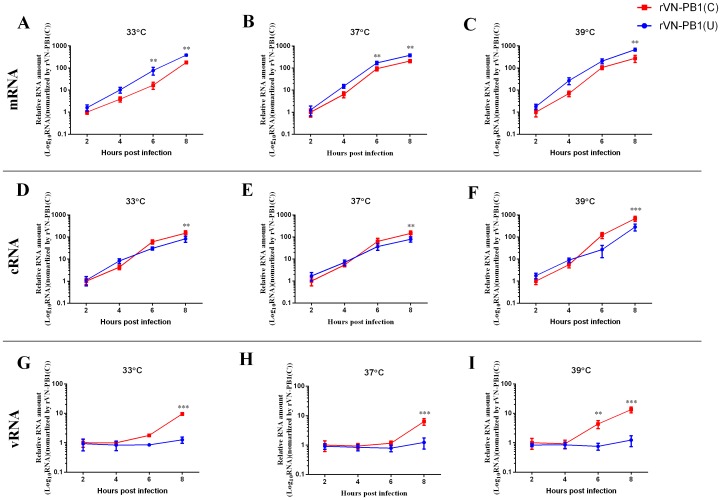
mRNA, cRNA and vRNA expression levels of PB1 gene.The three kinds of RNA relative RNA amounts at 33°C ((A), (D) and (G)), at 37°C (B), (E) and (H) and at 39°C (C), (E) and (I). All data in each figure were analyzed with 2−ΔΔCt method compared with the RNA amounts of rVN-PB1(C) virus at 2 h.p.i.. The mean relative activity and standard deviation (error bar) were calculated from the results of three independent experiments. The data were analyzed with two-way ANOVA using GraphPad Prism Software, and the P values were calculated. (*) P<0.05; (**) P<0.01; (***) P<0.001.